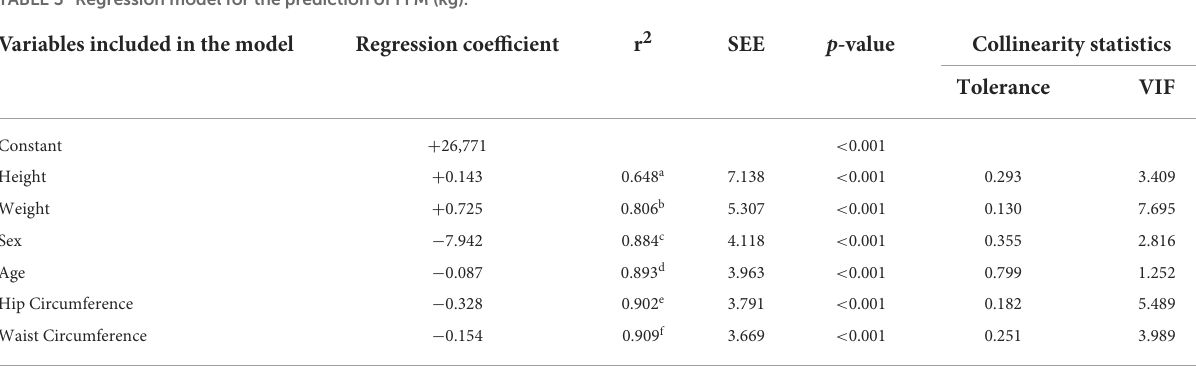
TABLE 3 Regression model for the prediction of FFM (kg).